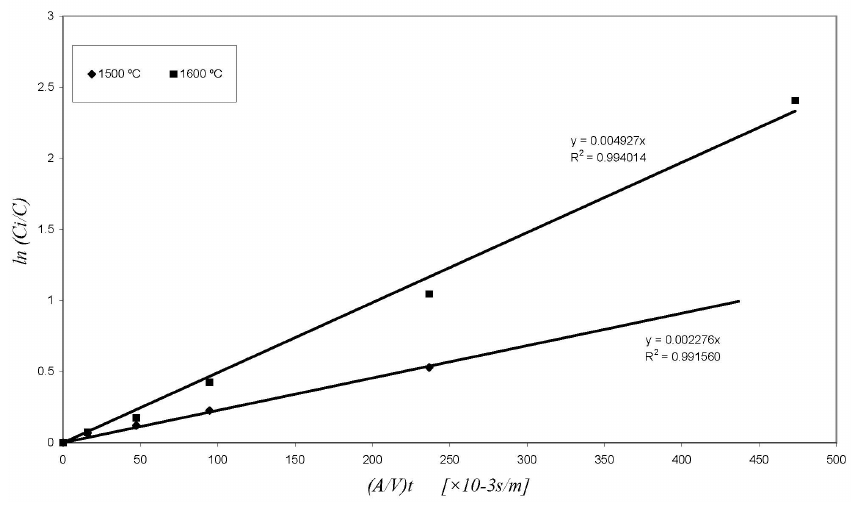
Figure 2. Relationship between ln . C i